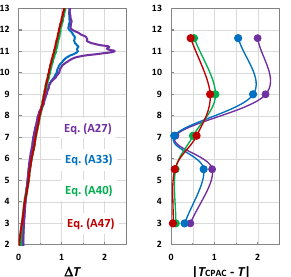
Figure 10. (1 April 2015) Comparative analysis of the absolute tem- perature uncertainties yielded by using Eqs. (A27), (A33), (A40), and (A47) and of the difference in modulus between temperature values retrieved from the CPACs and IMCES lidar